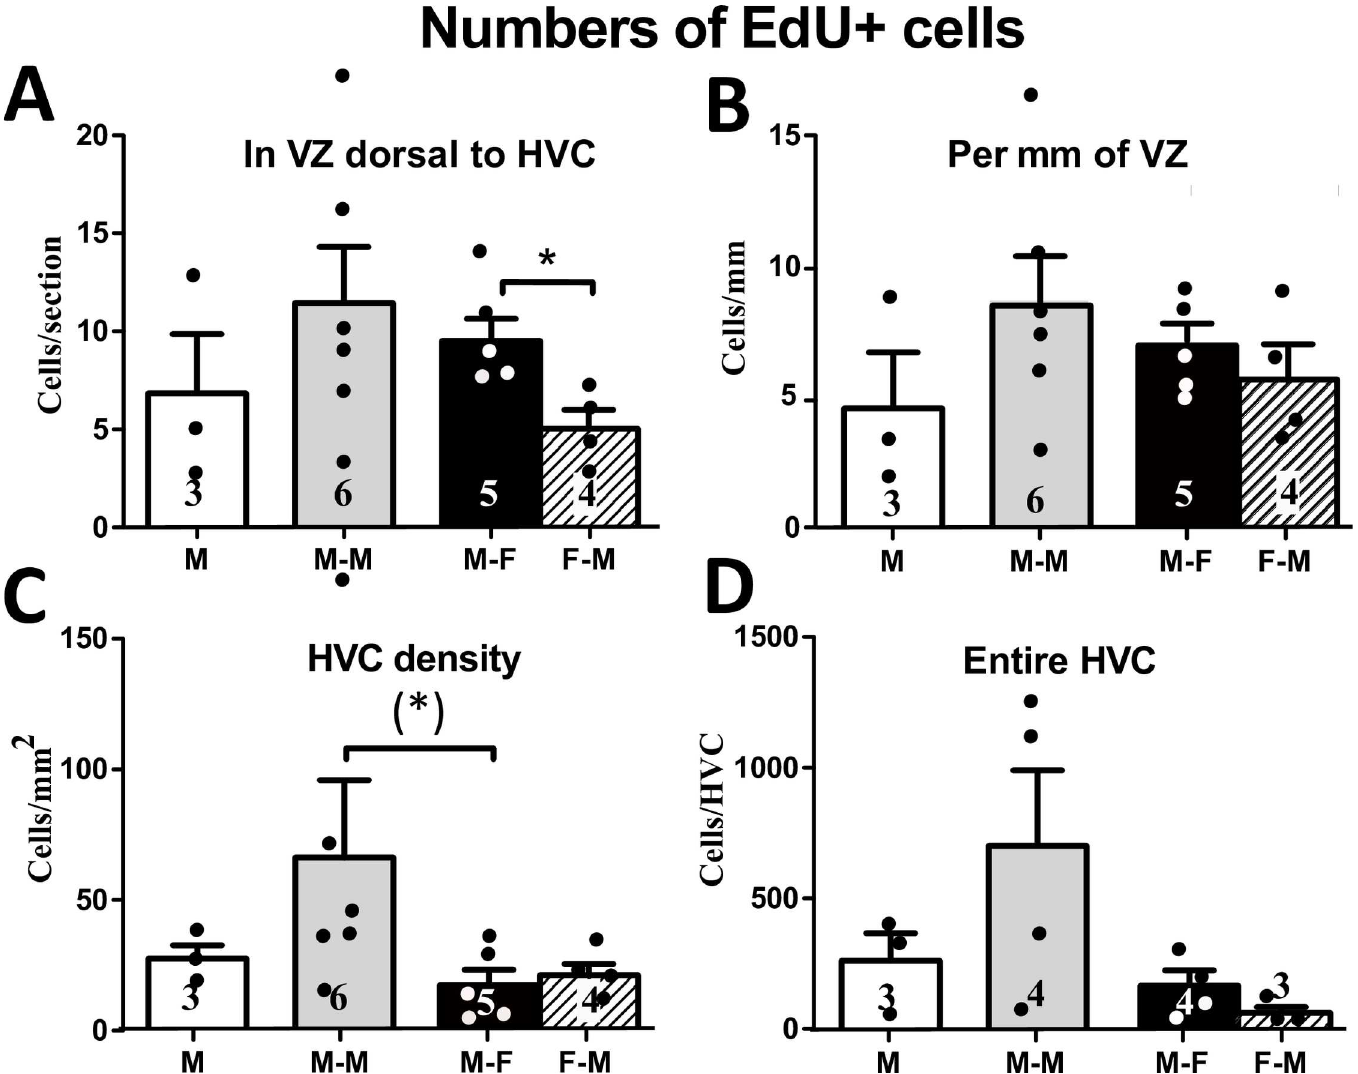
Fig 4. Number of EdU + cells in the VZ dorsal to HVC as an absolute number per section (A) and normalized by the length of the VZ (B). Density (number per mm 2 ) of EdU + cells in HVC (C) and numbers of EdU + cells estimated for the entire HVC (D). M: male-alone,M-M: male housed with another male, M-F: male housed with female, F-M: female housedwith a male. The figures on the bars indicatethe numbersof availabledata points. * = p < 0.05;( * ) = p < 0.05after an ANOVA showingonly a statistical tendency(p =